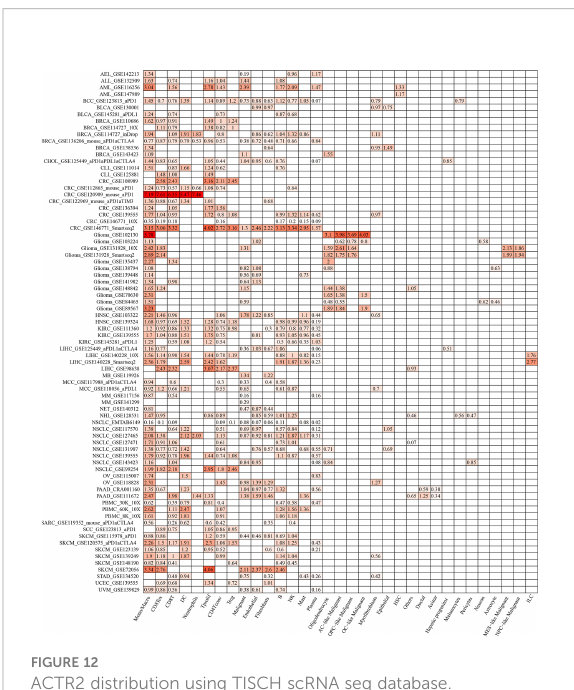
FIGURE 13 NCSTN distribution using TISCH scRNA seq